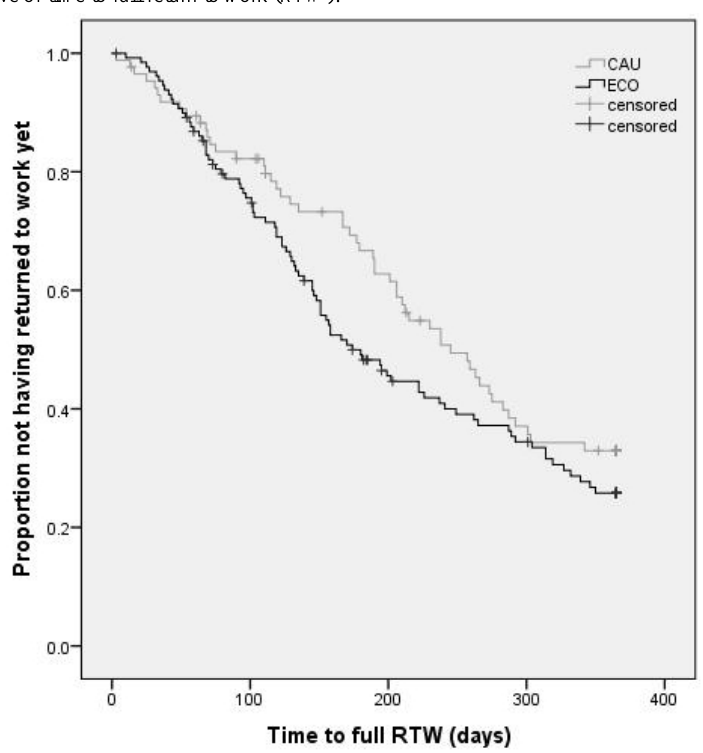
Figure 5. Kaplan-Meier curve of time to full return to work (RTW).